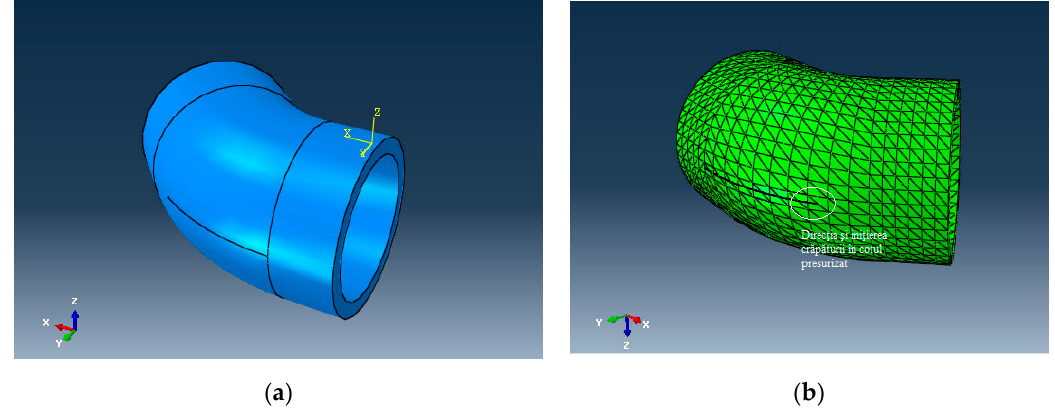
Figure 30. ( a ) Geometrical model of the elbow DN 31; ( b ) FE model of the elbow DN 315.